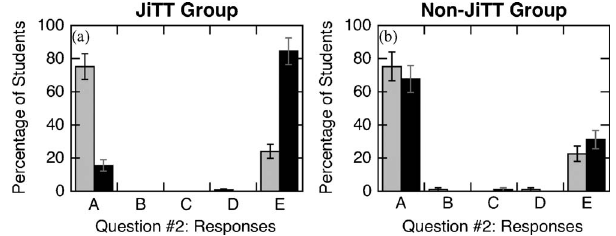
FIG. 3. Student responses to FCI question no. 2 on the pretest (cid:1) gray (cid:2) and post-test (cid:1) black (cid:2) . The correct response is E and the most commonly chosen distractor is A. (cid:1) a (cid:2) JiTT and (cid:1) b